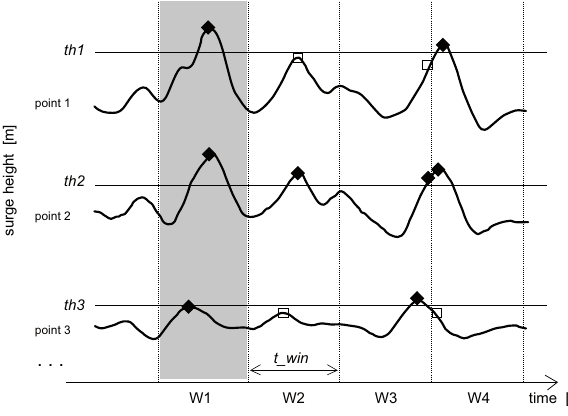
Fig. 3. Schematic description of the event definition. A sequence of adjacent time windows W1, W2, W3, W4 with duration t win is defined. Diamonds represent local maxima exceeding the thresholds th1, th2 and th3, squares - maxima not exceeding the thresholds for every time window. Only shaded W1 time window for which N (here 3) local maxima exceed the threshold yields an event.